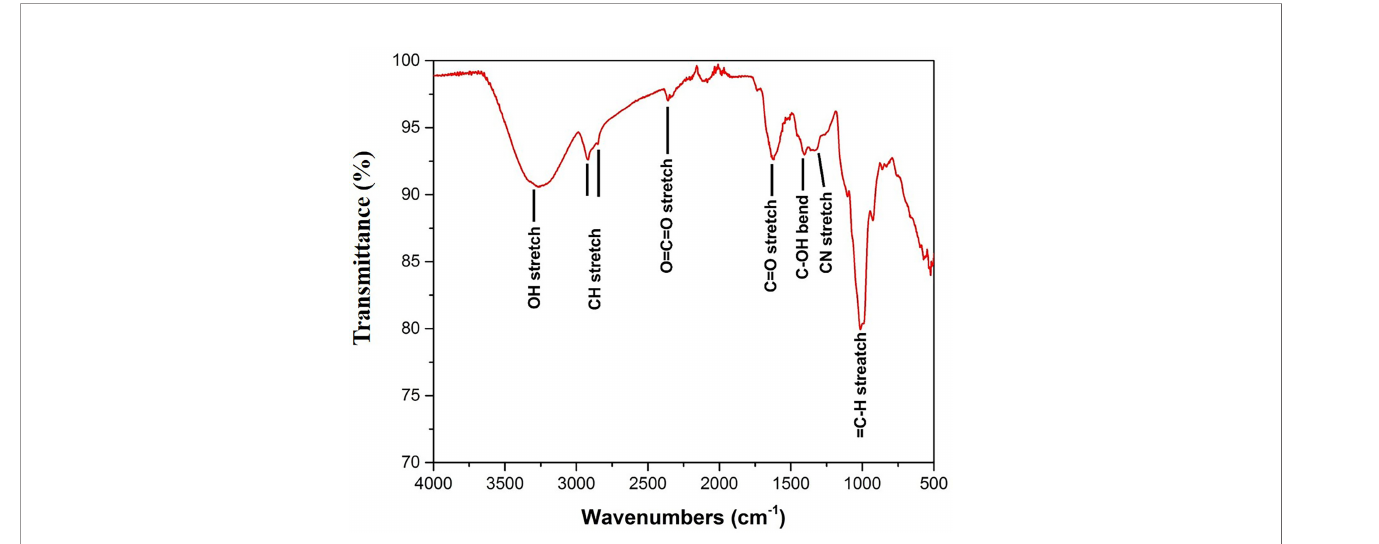
FIGURE 3 | FTIR spectra of U. indica extract. Extract was put on diamond crystal pedestal of ATR and readings were taken from 500 to 4,000 cm − 1